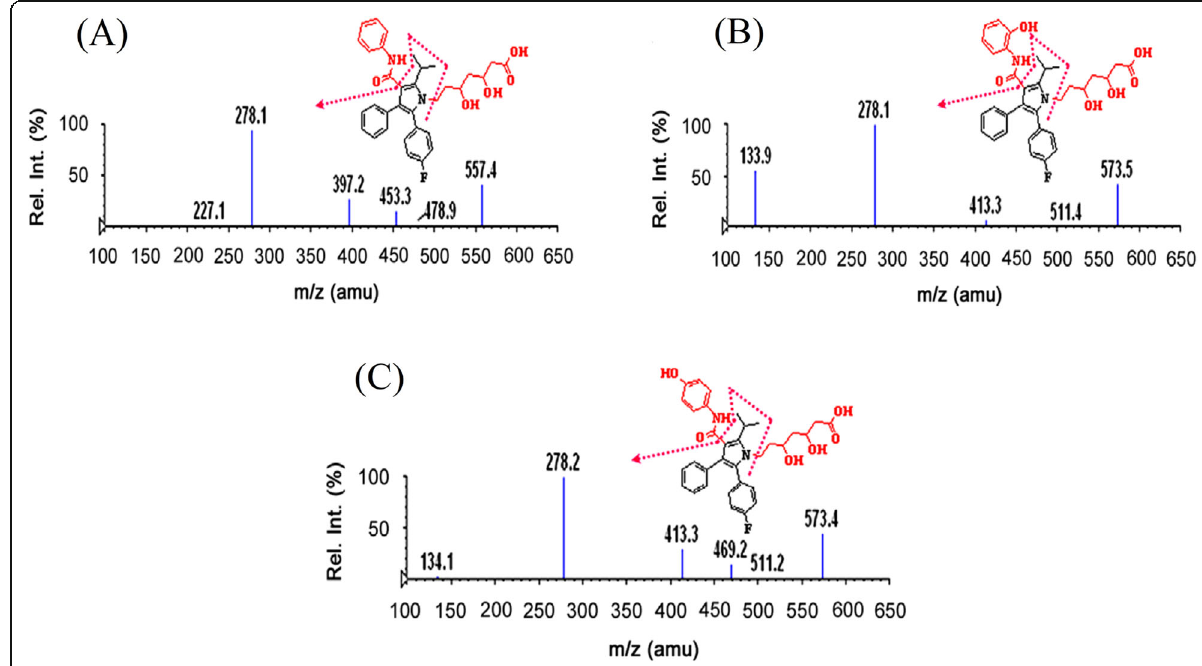
Fig. 3 Product ion spectra of a AT, b o-OH AT, and c p-OH AT in ESI − mode